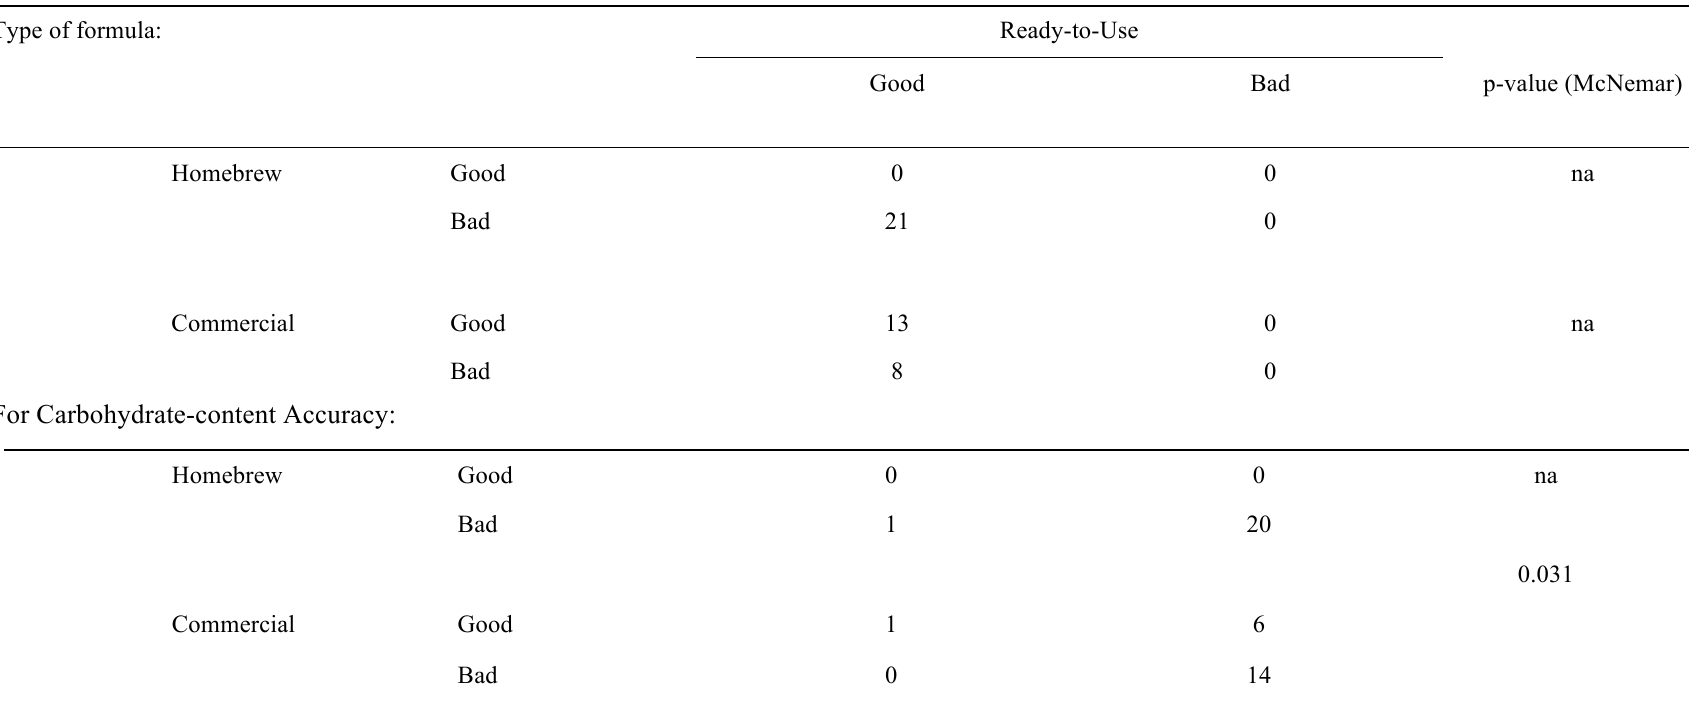
Table 2 Proportion of macronutrients accuracy of different enteral preparation formula for calorie-content accuracy For Calorie-content